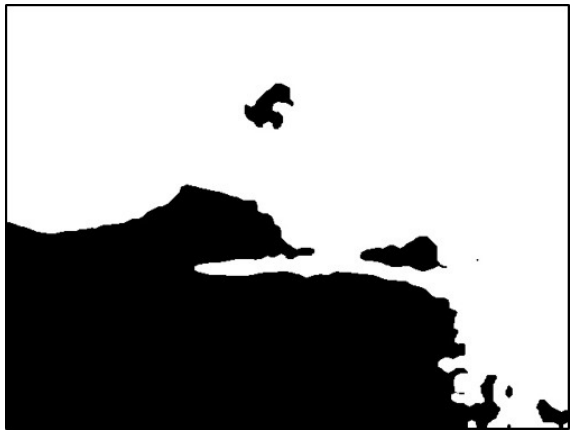
Figure 18. Result using dark group as the threshold.